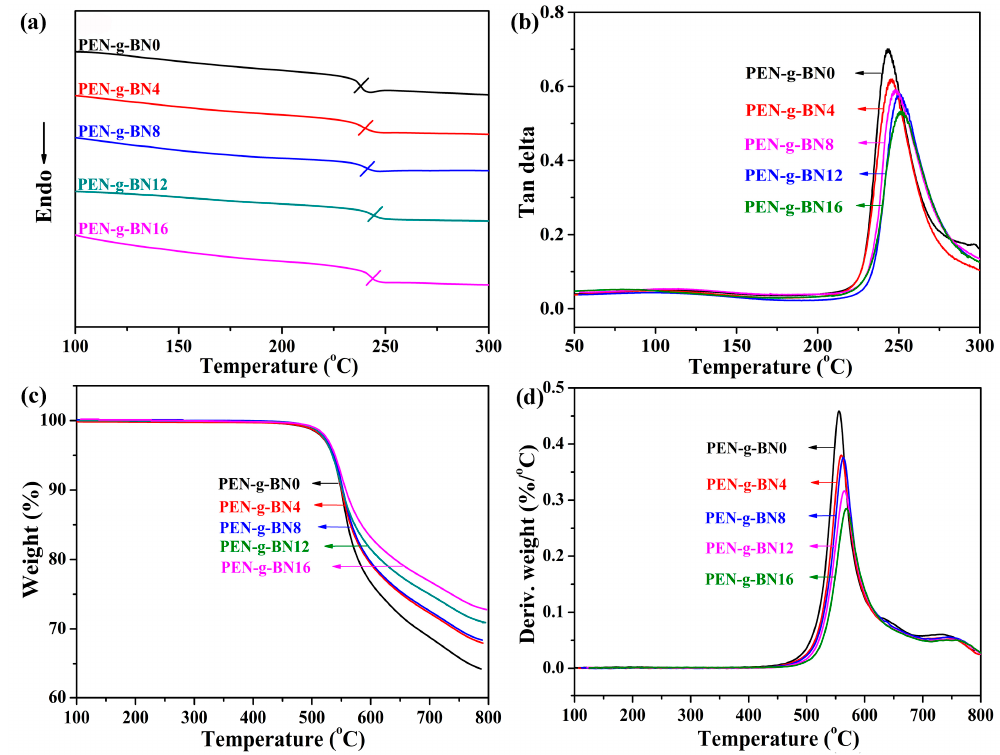
Figure 5. DSC curves ( a ), tan delta curves ( b ), TGA curves ( c ) and DTG curves ( d ) of the PEN-g-BN hybrids.